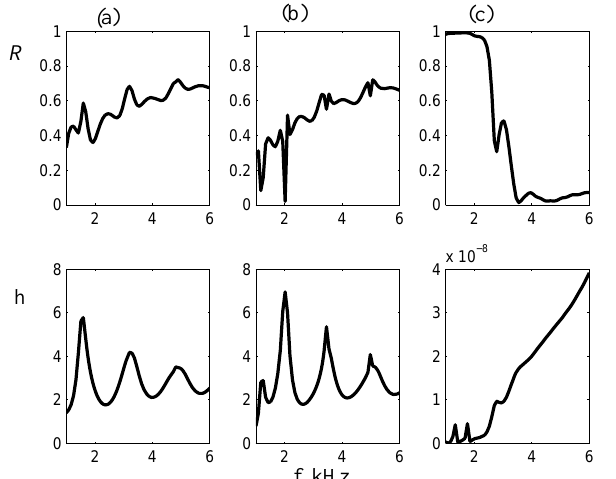
Figure 1. The plasma density (solid), the electron-neutral collision frequency (dashed), and the ion-neutral (dotted) collision frequency under conditions of the nighttime ionosphere.